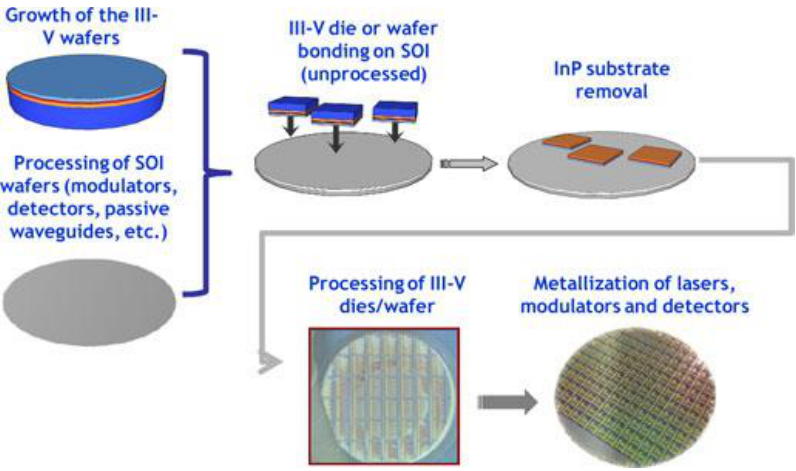
Figure 14. Process flow of hybrid integration of III-V materials on Si [151] (Reproduced with permission from Duan et al. , IEEE J. Sel. Top. Quantum Electron. ; published by IEEE,